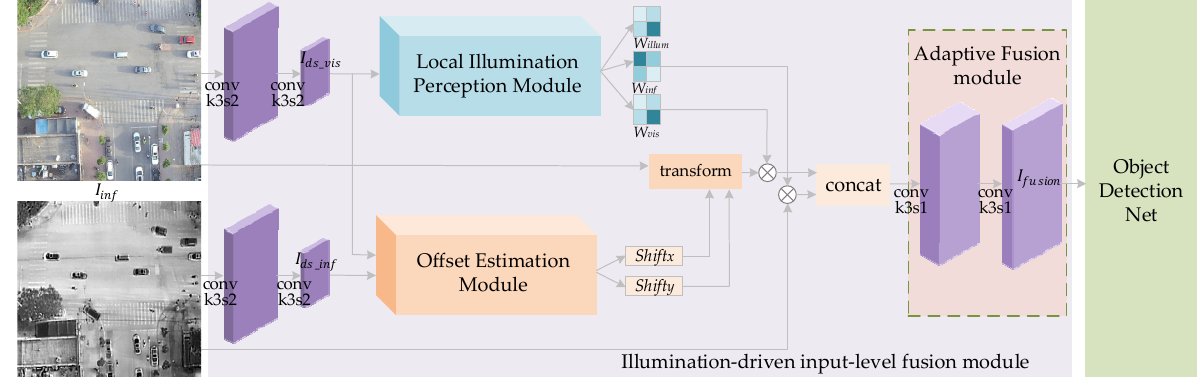
Figure 2. The overall framework of the local adaptive illumination-driven input-level fusion module. Conv k3s1 indicates that the convolutional kernel size is 3 and stride is set to 1. Then, I (cid:2914)(cid:2929)_(cid:2932)(cid:2919)(cid:2929) is input to the local illumination perception module to extract the